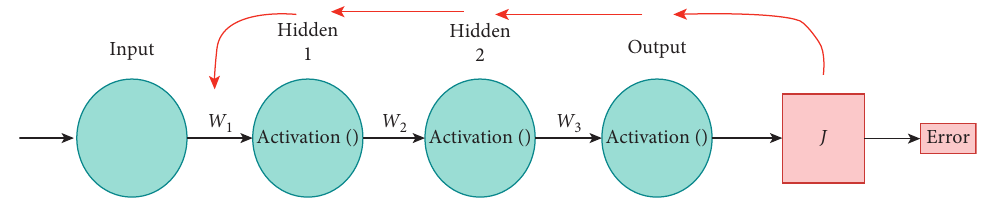
Figure 6: Backpropagation process where the generated error is backpropagated to weights W